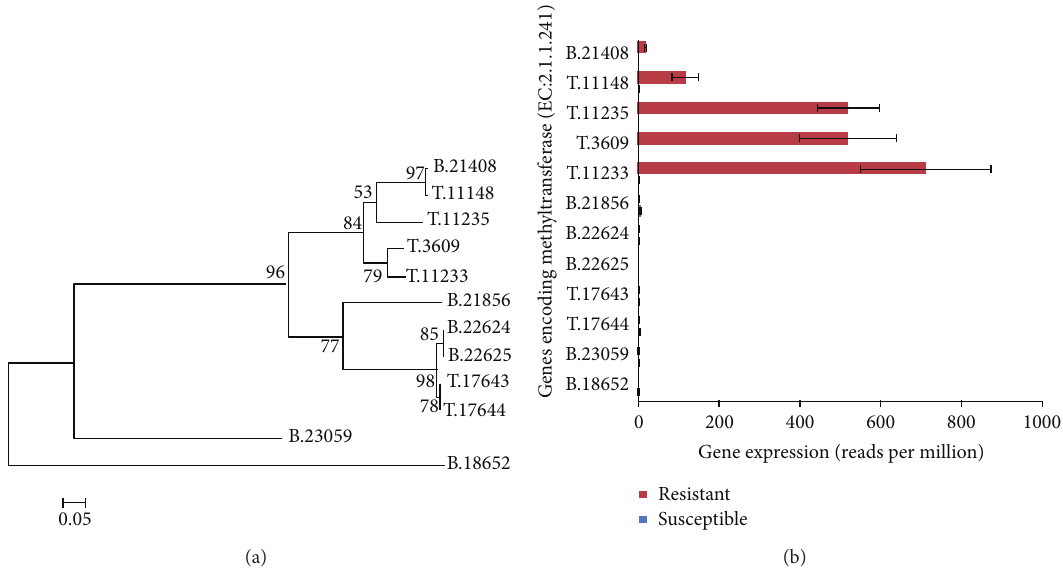
Figure 6: (a) Phylogenetic distance of genes encoding methyltransferases to produce DIMBOA-glucoside. (b) Comparison of transcripts abundance (reads per million, RPM) assembled unigenes encoding methyltransferases.